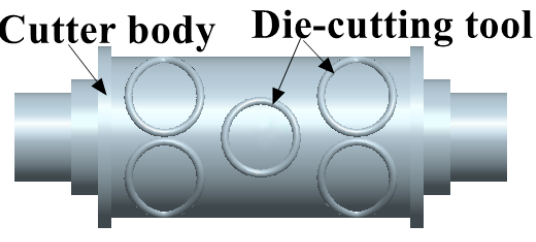
Figure 1. Schematic illustration of a facial cotton pad die-cutting tool.